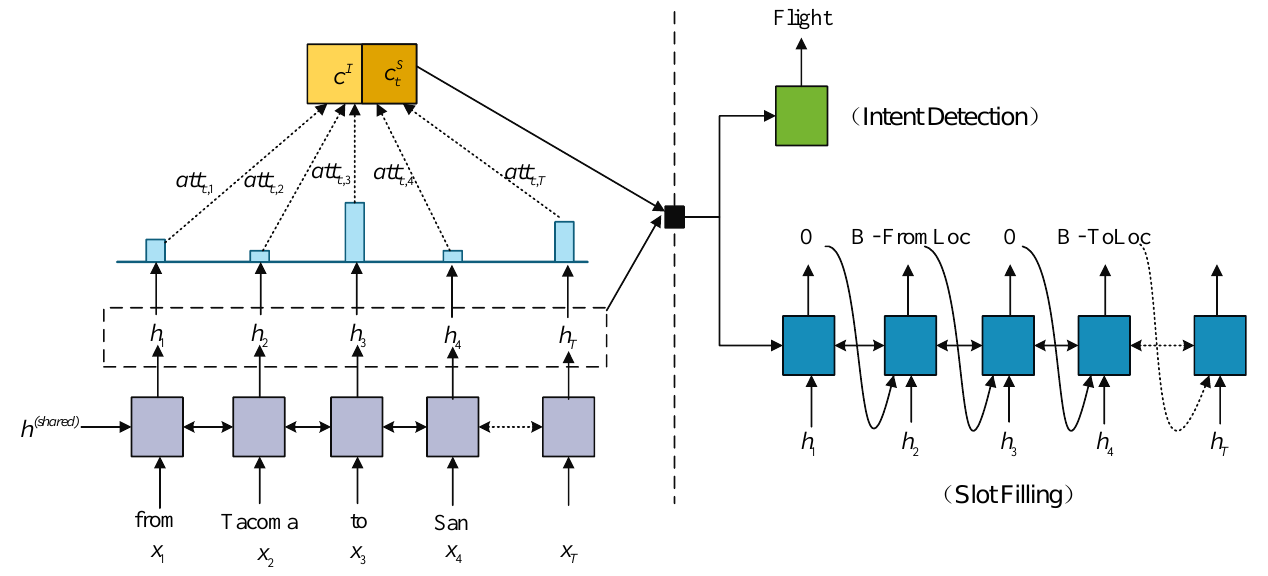
Figure 2. The structure of the intent-detection and slot-filling model. The O denotes the “ none ” type and B-X denotes that the segment in which this token resides is of type X and that this token is at the beginning of the segment.